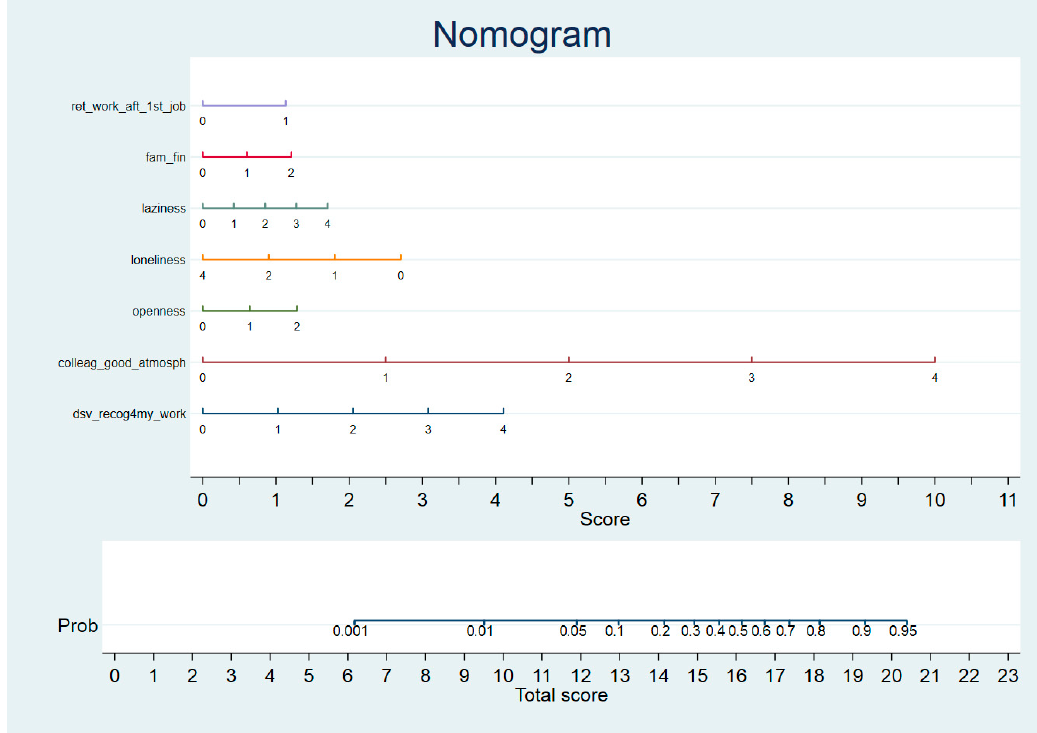
Figure 3. Full job satisfaction prediction nomogram for a regional model (Table 3, scenario b), corresponding to the second Romanian historical region being analyzed (TBCM).